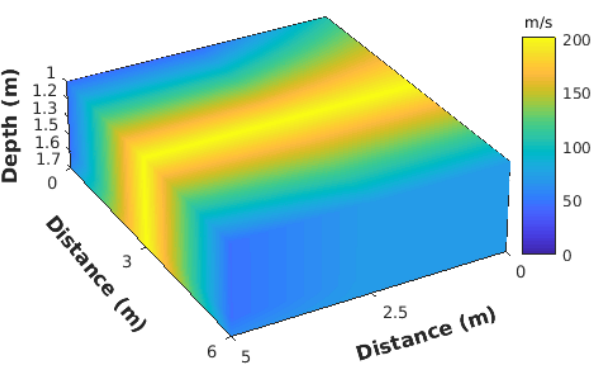
Figure 14. 3D velocity subsurface. Layers between 1 and 1.7